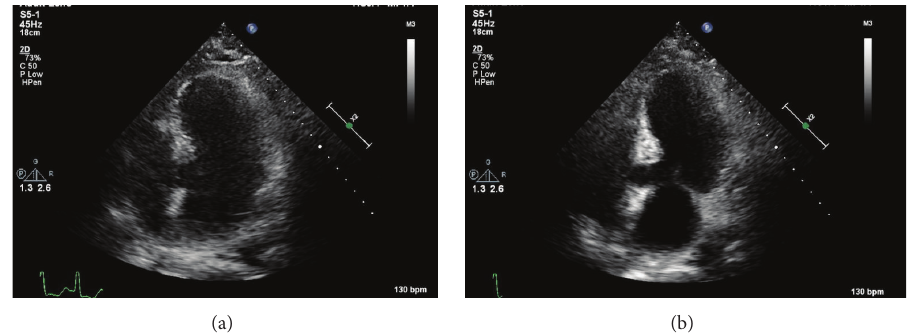
Figure 5: Echocardiographic evidence of classic takotsubo cardiomyopathy, the apical type. (a) represents diastole and (b) represents systole.